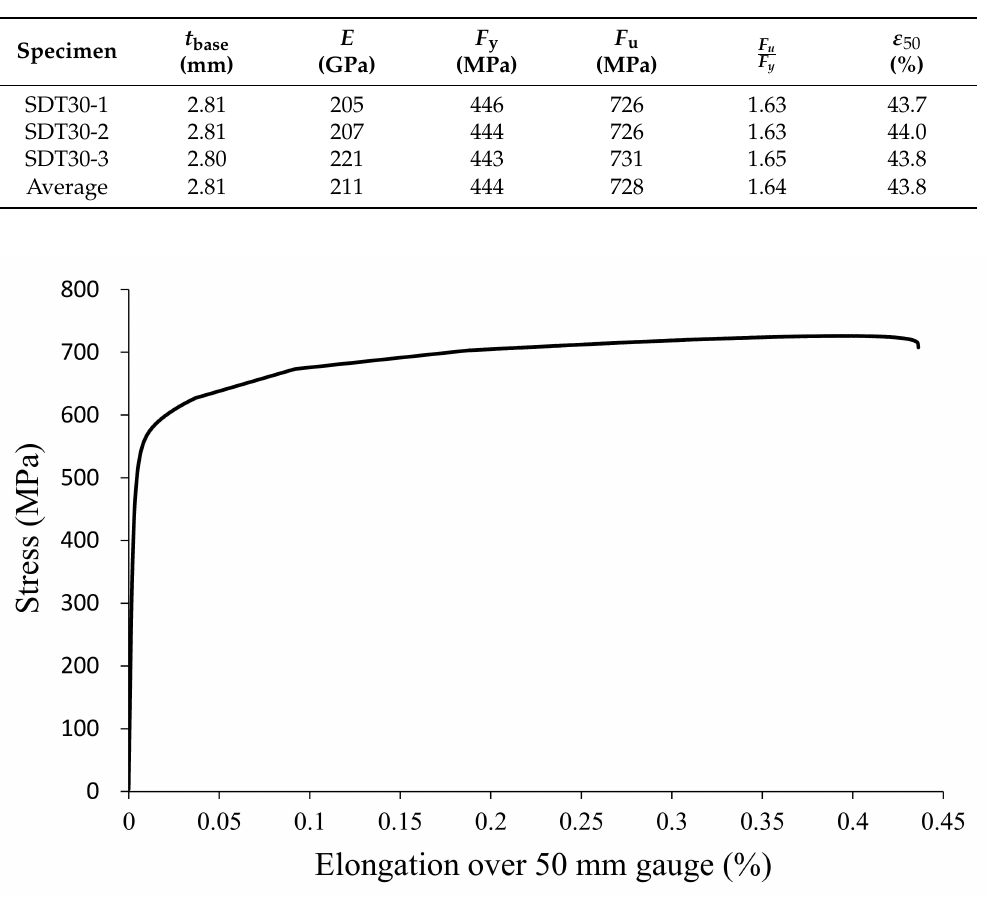
Figure 1. Stress–strain response of lean duplex stainless